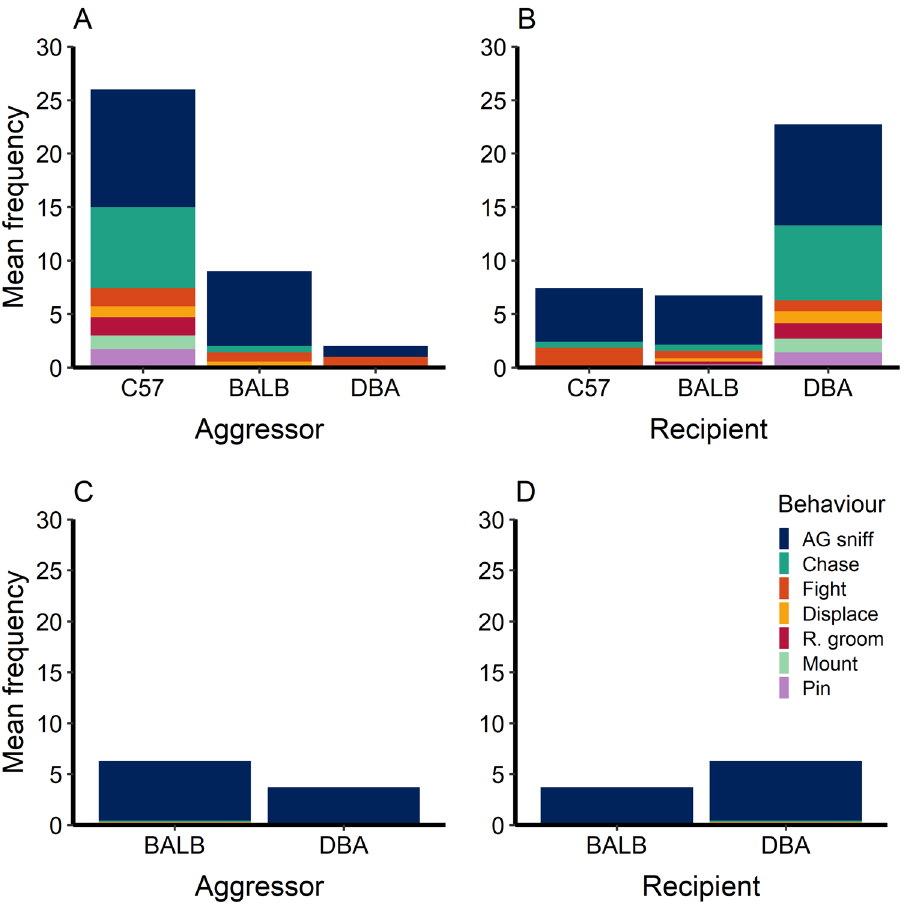
Figure 5. Mean frequency of agonistic behaviours observed in the playpens, shown separately by strain. Panel ( A ) shows behaviours according to aggressor strain while C57 mice were present. Panel ( B ) shows behaviours according to recipient strain with C57 mice present. Panel ( C ) shows aggressors with C57 mice absent, and Panel ( D ) shows recipients with C57 mice absent. C57 mice were present for two trials and absent for two trials. “AG sniff” stands for anogenital sniffing, and “R. groom” stands for rough grooming. Note that when mice were fighting, the mice involved were labelled as both the aggressor and the recipient. n = 21 mice, with 7 mice of each